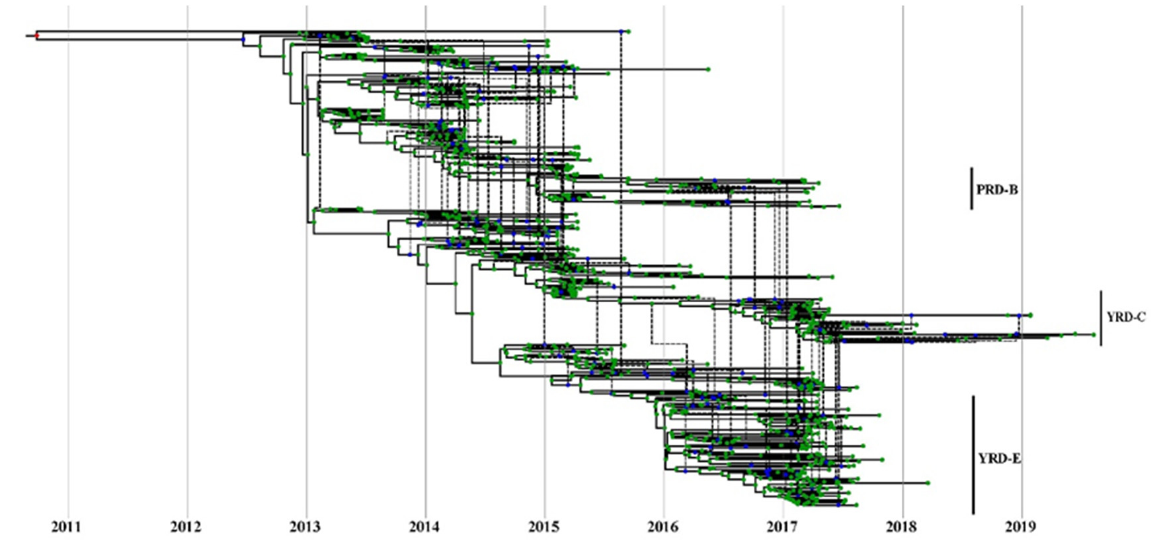
Figure 6. Estimate of MCC reassortment network between HA and NA genes of H7N9 viruses. Icytree visualizes the network as a base tree connected by dotted branches, indicating a reassortment event. The green dots indicate the tips of the tree.